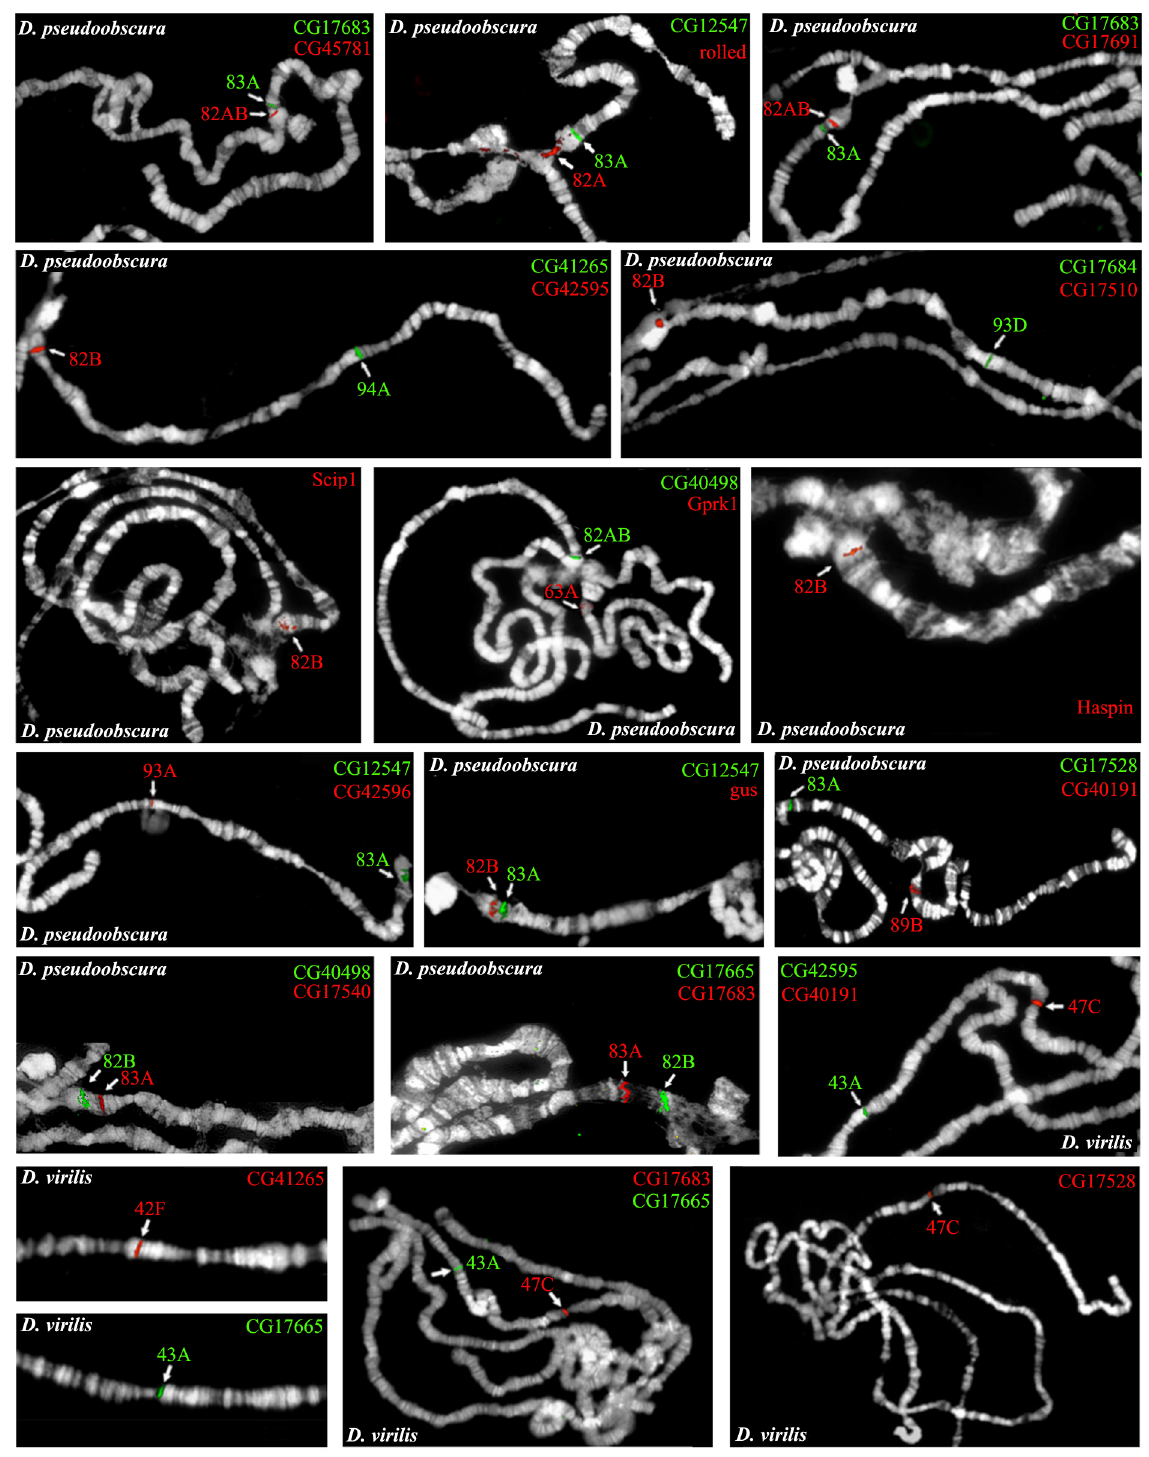
Fig 3. Examples of FISH mapping of D . melanogaster heterochromatin gene orthologs. The panels show single or double- colour FISH mapping of orthologs to polytene chromosomes of D . pseudoobscura and D . virilis using specific PCR probes. Each ortholog is designated with the name of the corresponding D . melanogaster